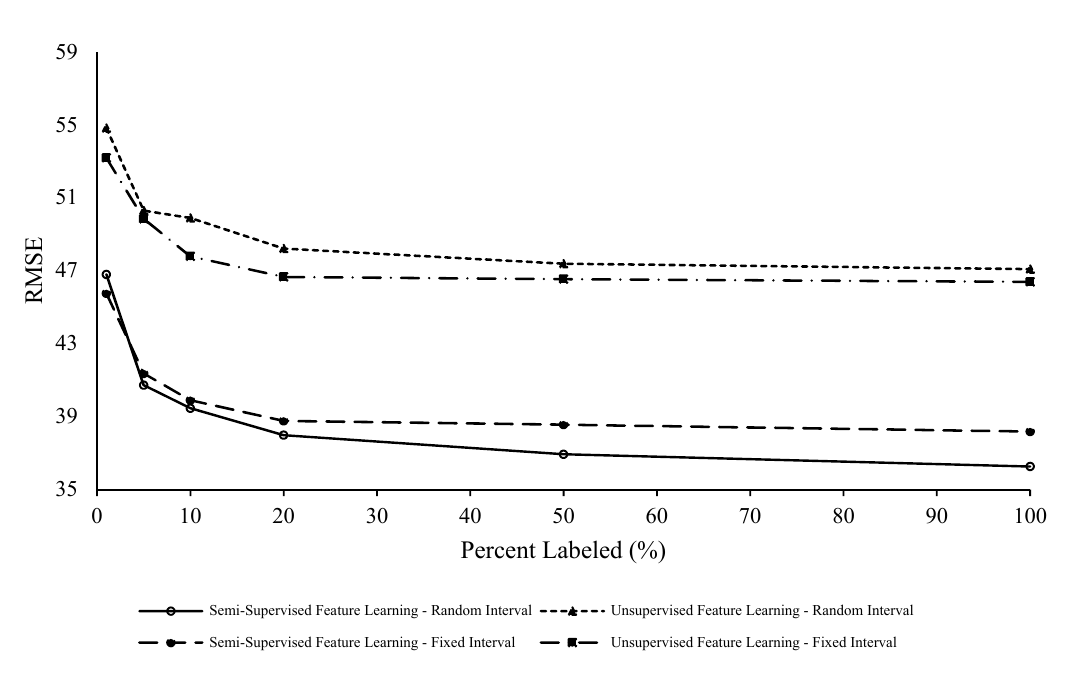
Figure 10. FD004 RMSE versus percent labeled (%).